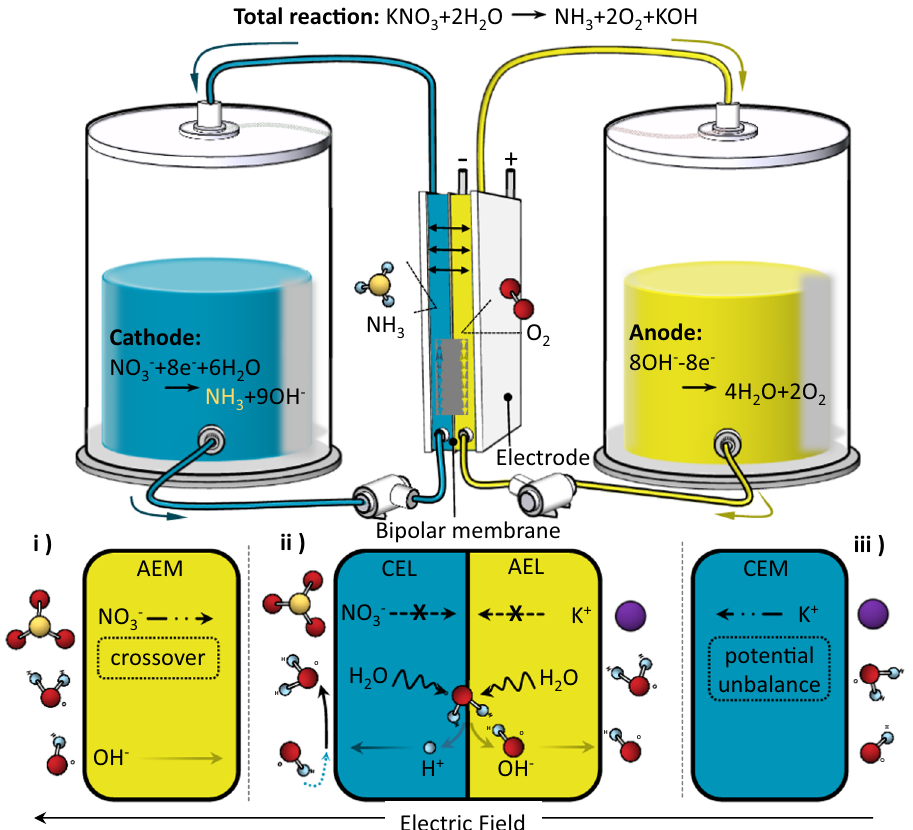
Fig.1|SchematicillustrationofcontinuousNH 3 electrosynthesiswithabipolar membrane reactor. The fl ow directions of ions referred to in this process when